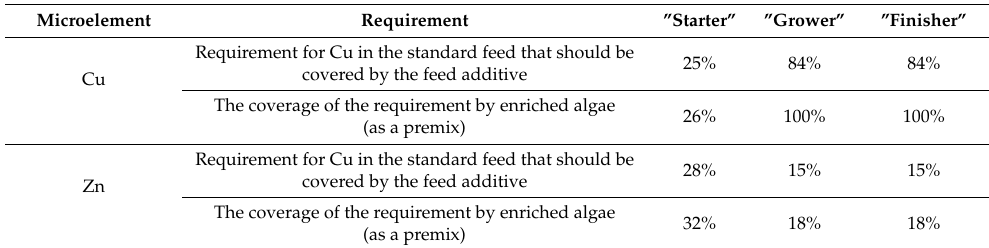
Table 2. Enriched with microelements Enteromorpha sp. added to the mixtures in order to cover the requirement for Cu and Zn (%).